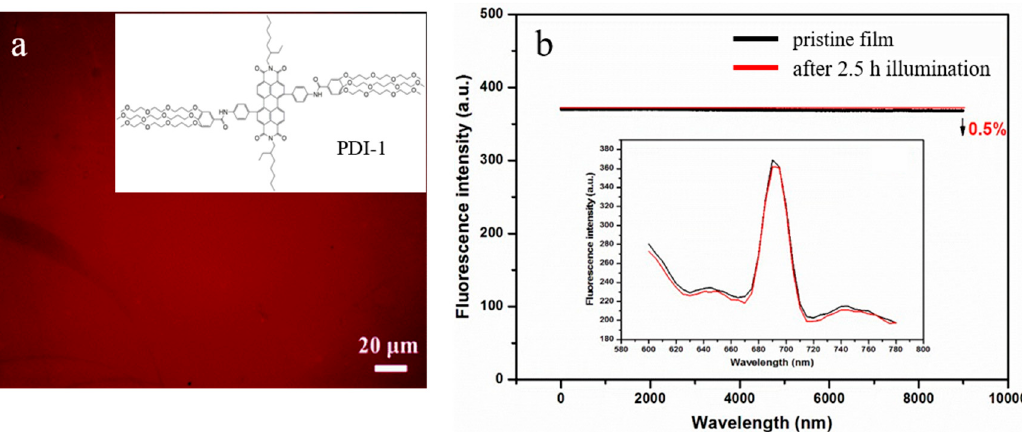
Figure 3. ( a ) Fluorescence microscopy image of the as-prepared PDI-1 based LB film; ( b ) Fluorescence intensity of PDI-1 based LB film (before and after 2.5 h illumination) recorded at the emission maximal wavelength 690 nm ( λ ex = 460 nm, 150 W. Xe Lamp) as a function of time; the almost no decrease in fluorescence intensity (usually caused by photobleaching) indicates the extremely strong robustness of the PDI film fabricated [25]. The inset shows the full fluorescence spectra of the same film before and after 2.5 h illumination.